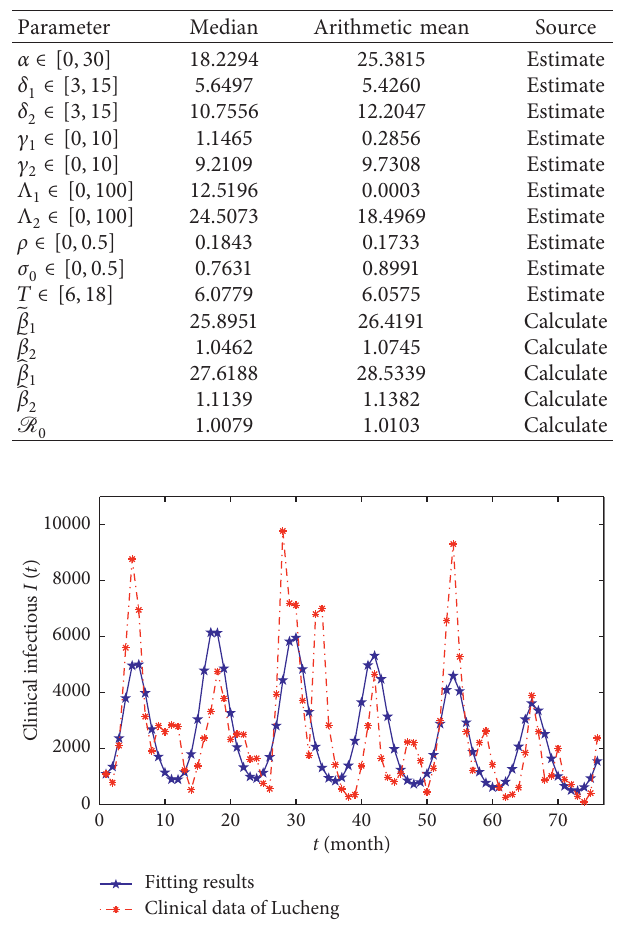
Figure 3: The reported data vs. the numerical solution of the HFMD model (1) in